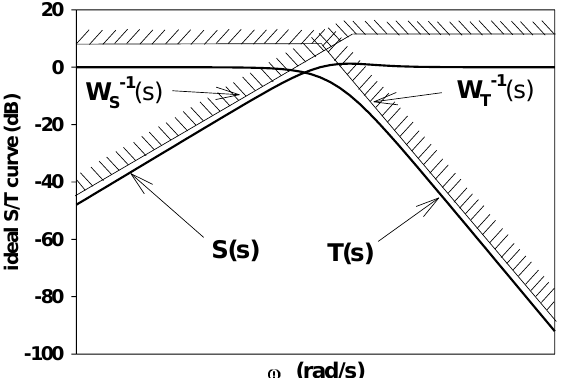
Figure 8. Ideal S/T curve. S ( s ) is the sensitivity function, T ( s ) is complementary sensitivity function, W S ( s ) is weight function for system quality, and W T ( s ) is weight function for stability.